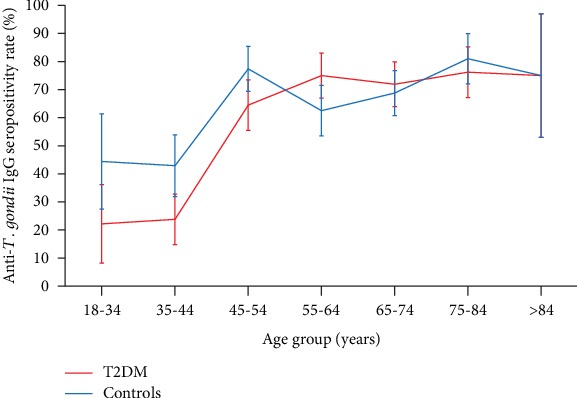
Seroprevalence of anti-T. gondii IgG antibodies among patients with T2DM and control subjects, stratified by age group. BHS, Western Australia. Average rate of seropositivity increase was calculated at 0.97% and 0.57%, per year of age, for the T2DM and control groups, respectively. Error bars represent standard error of the respective proportions.